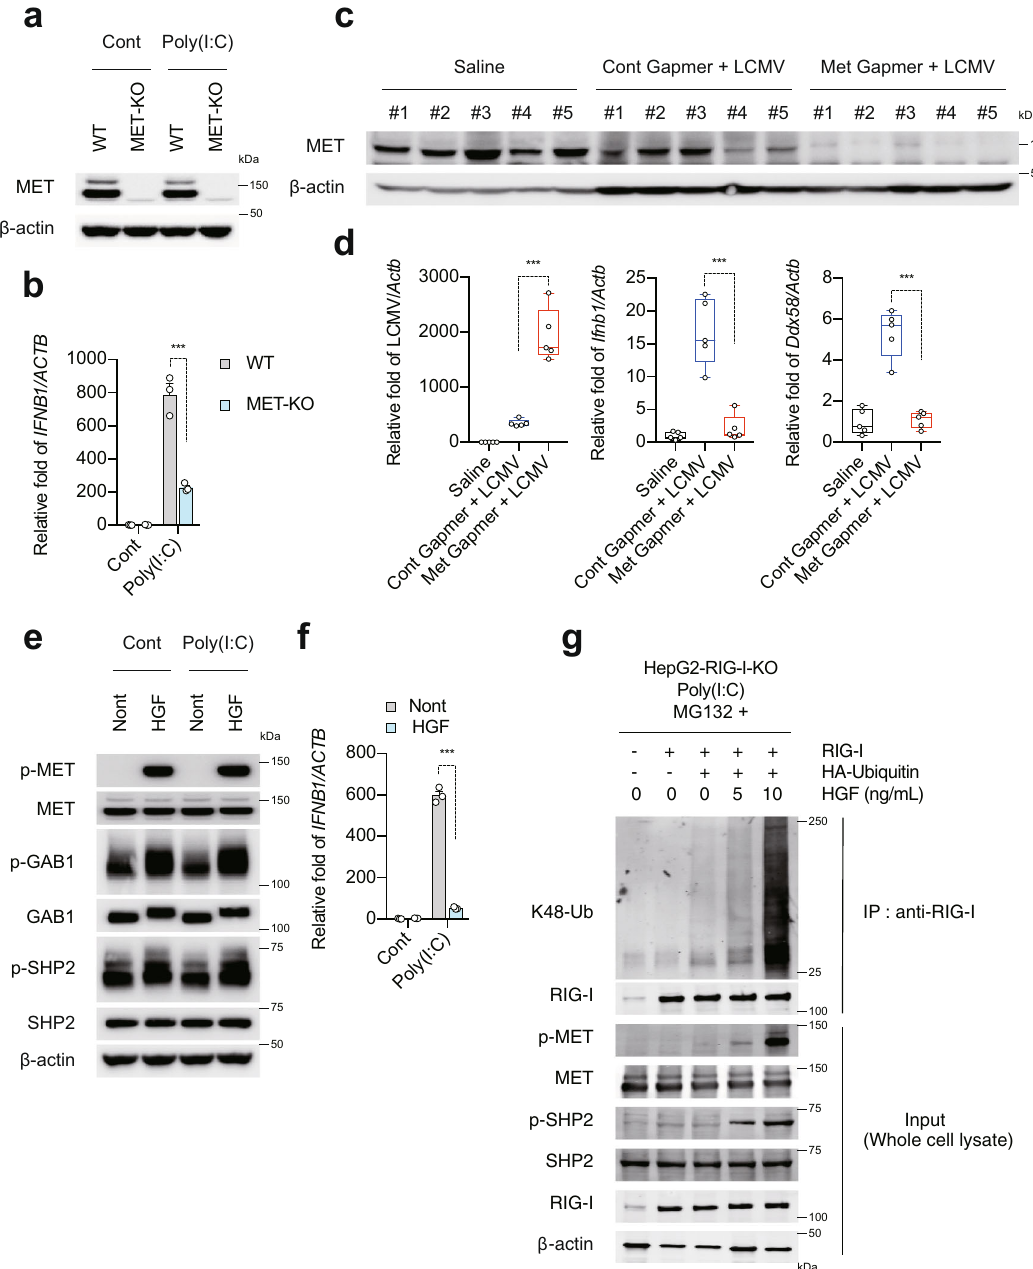
Fig. 3 MET has an important role in innate immune responses. a Immunoblot analysis of MET and β -actin in HepG2-WT and HepG2-MET-KO cells at 12 h after Cont or Poly(I:C) transfection. b qRT-PCR analysis of IFNB1 in HepG2-WT and HepG2-MET-KO cells at 12 h after Cont or Poly(I:C) transfection. Results were normalised to those of ACTB . Data shown are means of 3 technical replicates ± SEM. *** p < 0.001 by two-way ANOVA with Tukey ’ s multiple comparison test. c , d C57BL/6J mice were injected intravenously with Cont Gapmer or Met Gapmer, and at 1 day after injection, the mice were infected intraperitoneally with 1.0 × 10 4 pfu LCMV. c Immunoblot analysis of MET and β -actin in the liver of WT mice at 5 days after LCMV infection. d qRT-PCR analysis of LCMV, Ifnb1 and Ddx58 in the liver of WT mice at 5 days after LCMV infection. Data shown are means of 5 biological replicates ± SEM. *** p < 0.001 by two-way ANOVA with Tukey ’ s multiple comparison test. Boxplots: centre line, median; box limits, 25 to 75th percentiles; whiskers, min